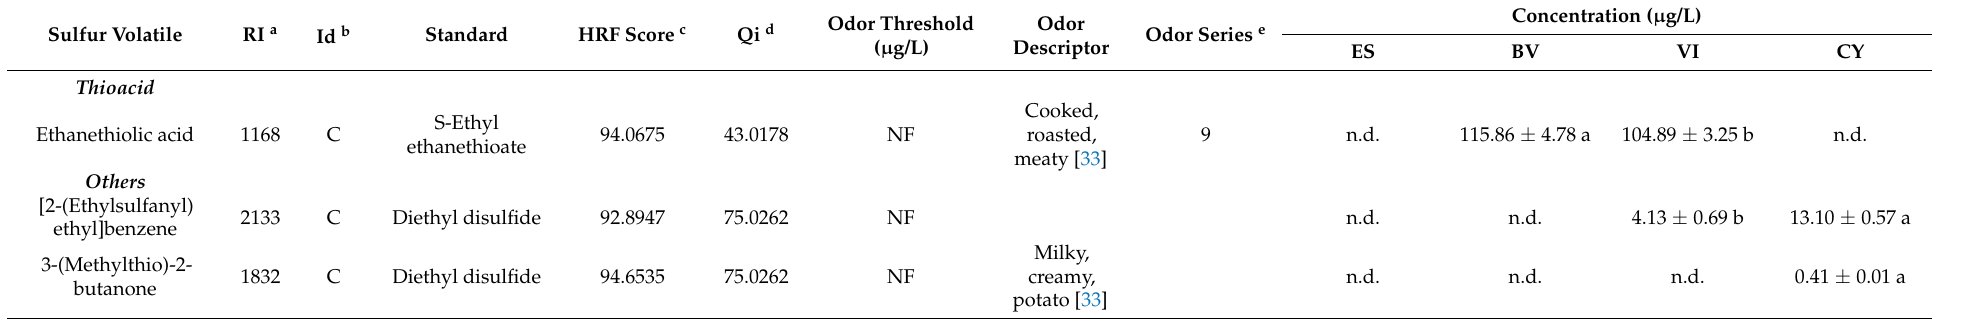
a Retention indices on DB-wax column, b Identification of the compounds: ‘A’ means identified by mass spectrum and RI agree with standards, ‘B’ means tentatively identified by mass spectrum, agrees with the mass spectral database and RI agrees with literature, ‘C’ means high-resolution filtering score and mass spectral database. c HRF (high-resolution filtering score); percentage of the spectrum obtained by MS Orbitrap that can be explained by combination of accurate mass, library matching and percentage of explained ions observed. d Quantitative ion. e 1 = fruity, 2 = floral, 3 = herbaceous (or vegetal), 4 = nutty, 5 = caramel, 6 = earthy, 7 = chemical, 8 = fatty, 9 = roasted. f NF: not found. g 2-Methyltetrahydrothiophen-3-one. h